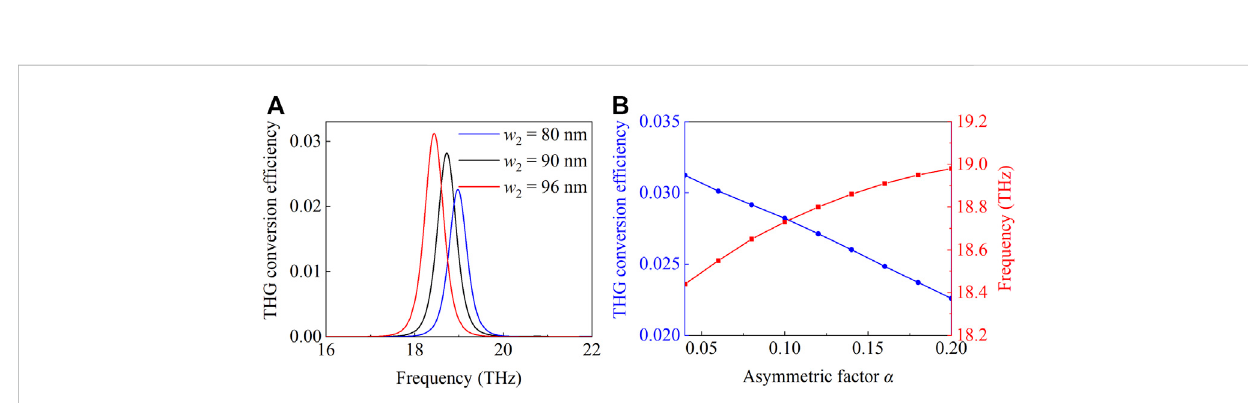
FIGURE 6 (A) THG conversion ef fi ciency versus the fundamental frequency for different widths w 2 . (B) THG conversion ef fi ciency and fundamental frequency of the quasi-BICs dependence on the asymmetric factor α . The other parameters are p = 300 nm, w 2 = 90 nm, h 1 = 52 nm, h 2 = 1,350 nm, E f 1 = 0.2 eV, and E f 2 = 1